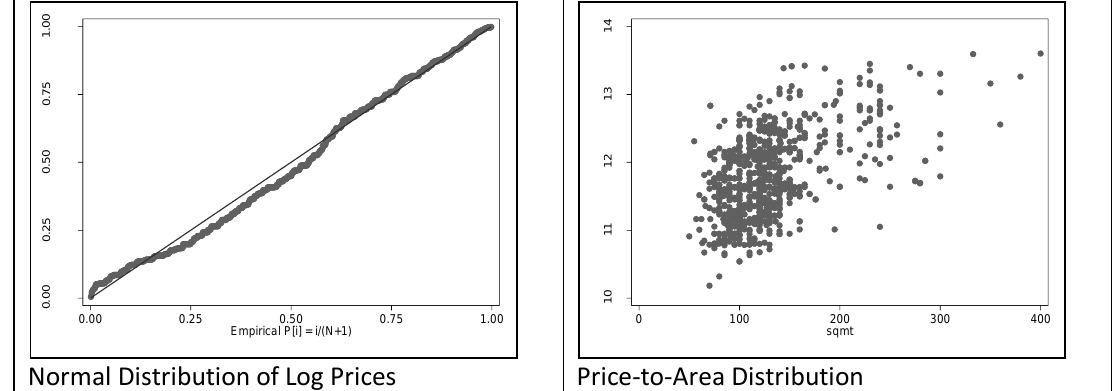
Figure 2 Log price to normal distribution and price to housing area scatter